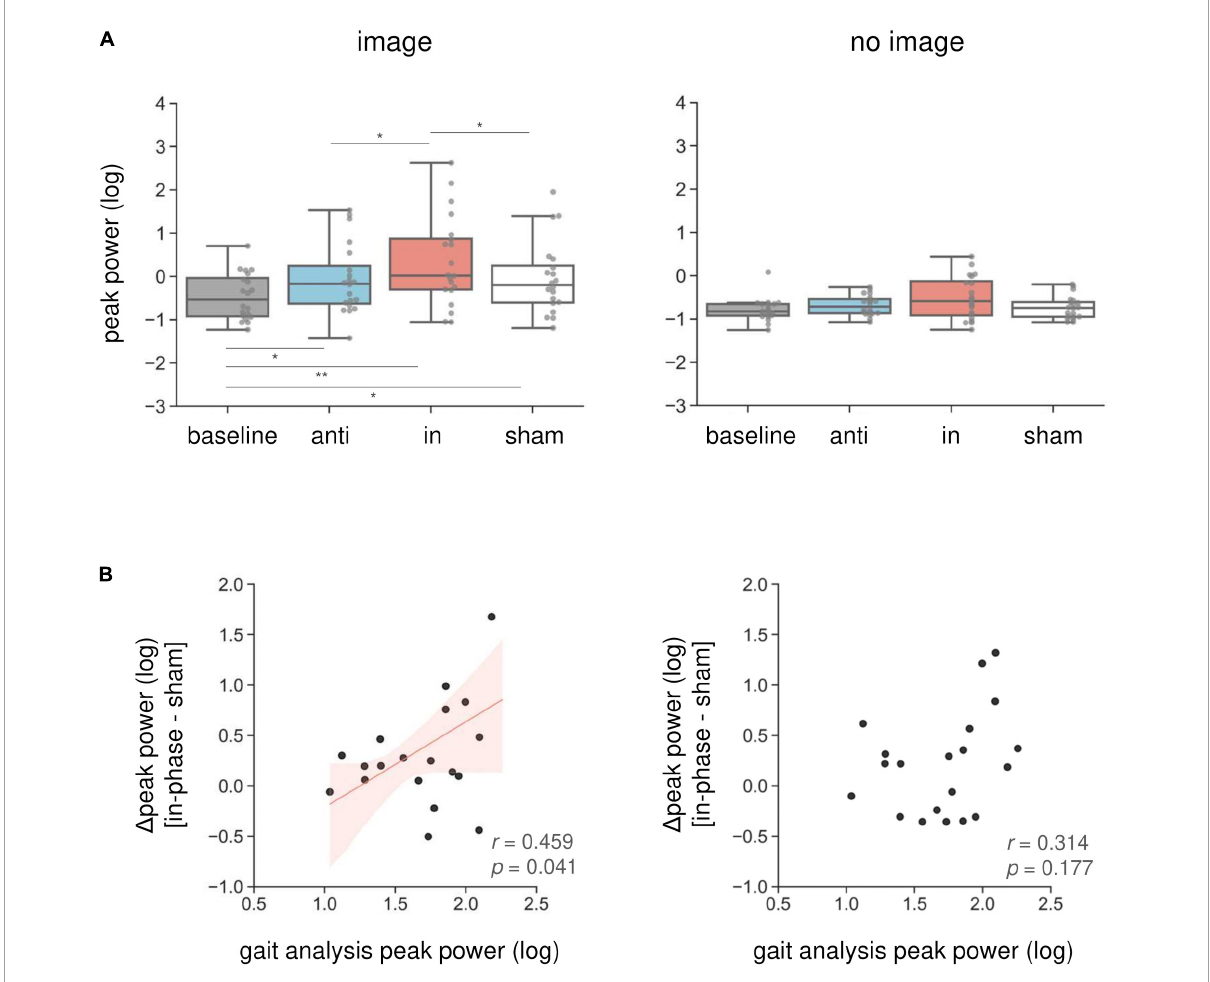
FIGURE6 Imagery-specific effects on the yaw axis. (A) Effects of combined stimulation on the yaw peak power in the imagery (left) and no-imagery (right) sessions. In-phase stimulation increased the yaw peak power compared with the other conditions, while there were no differences in the no-imagery session. (B) The relationship between in-phase stimulation and actual locomotion on the yaw axis. The peak power in the sham condition was subtracted from the in-phase stimulation peak power to calculate the (cid:49) peak power. Correlations between the yaw peak power during gait and the (cid:49) peak power during in-phase stimulation were calculated in the imagery (left) and no-imagery (right) sessions. Positive correlations were only observed in the imagery session. The regression lines are shown in red. The shaded areas reflect the 95% confidence interval. * p < 0.05, ** p <